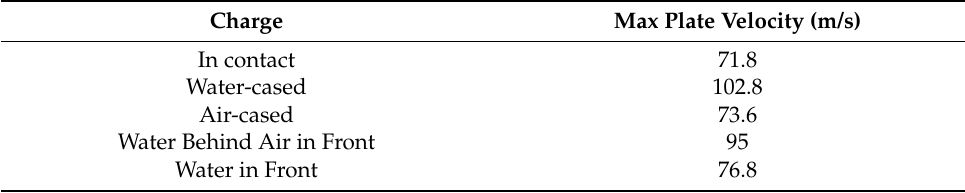
Table 3. Velocity of the plate in each simulation.